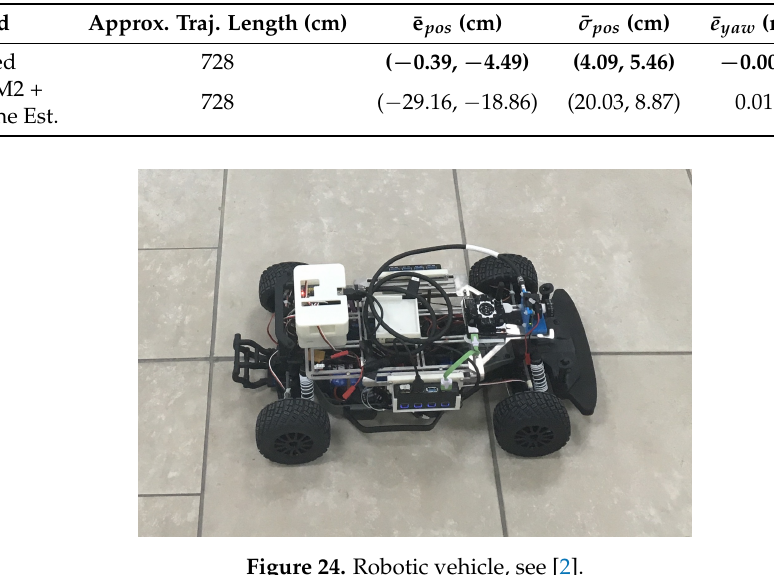
Figure 24. Robotic vehicle, see [2].